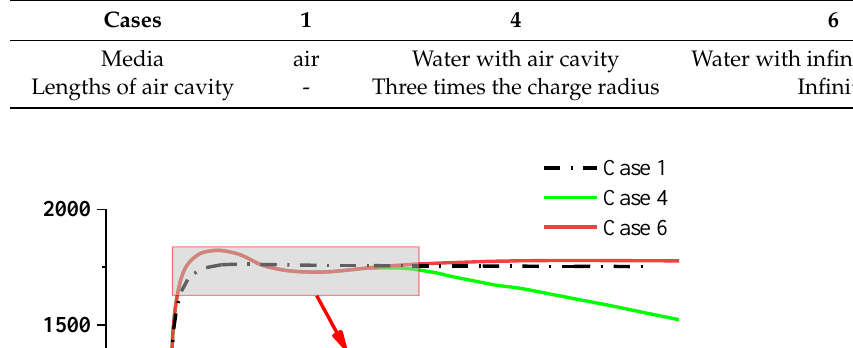
Table 11. Cases discussed in the pit stage.